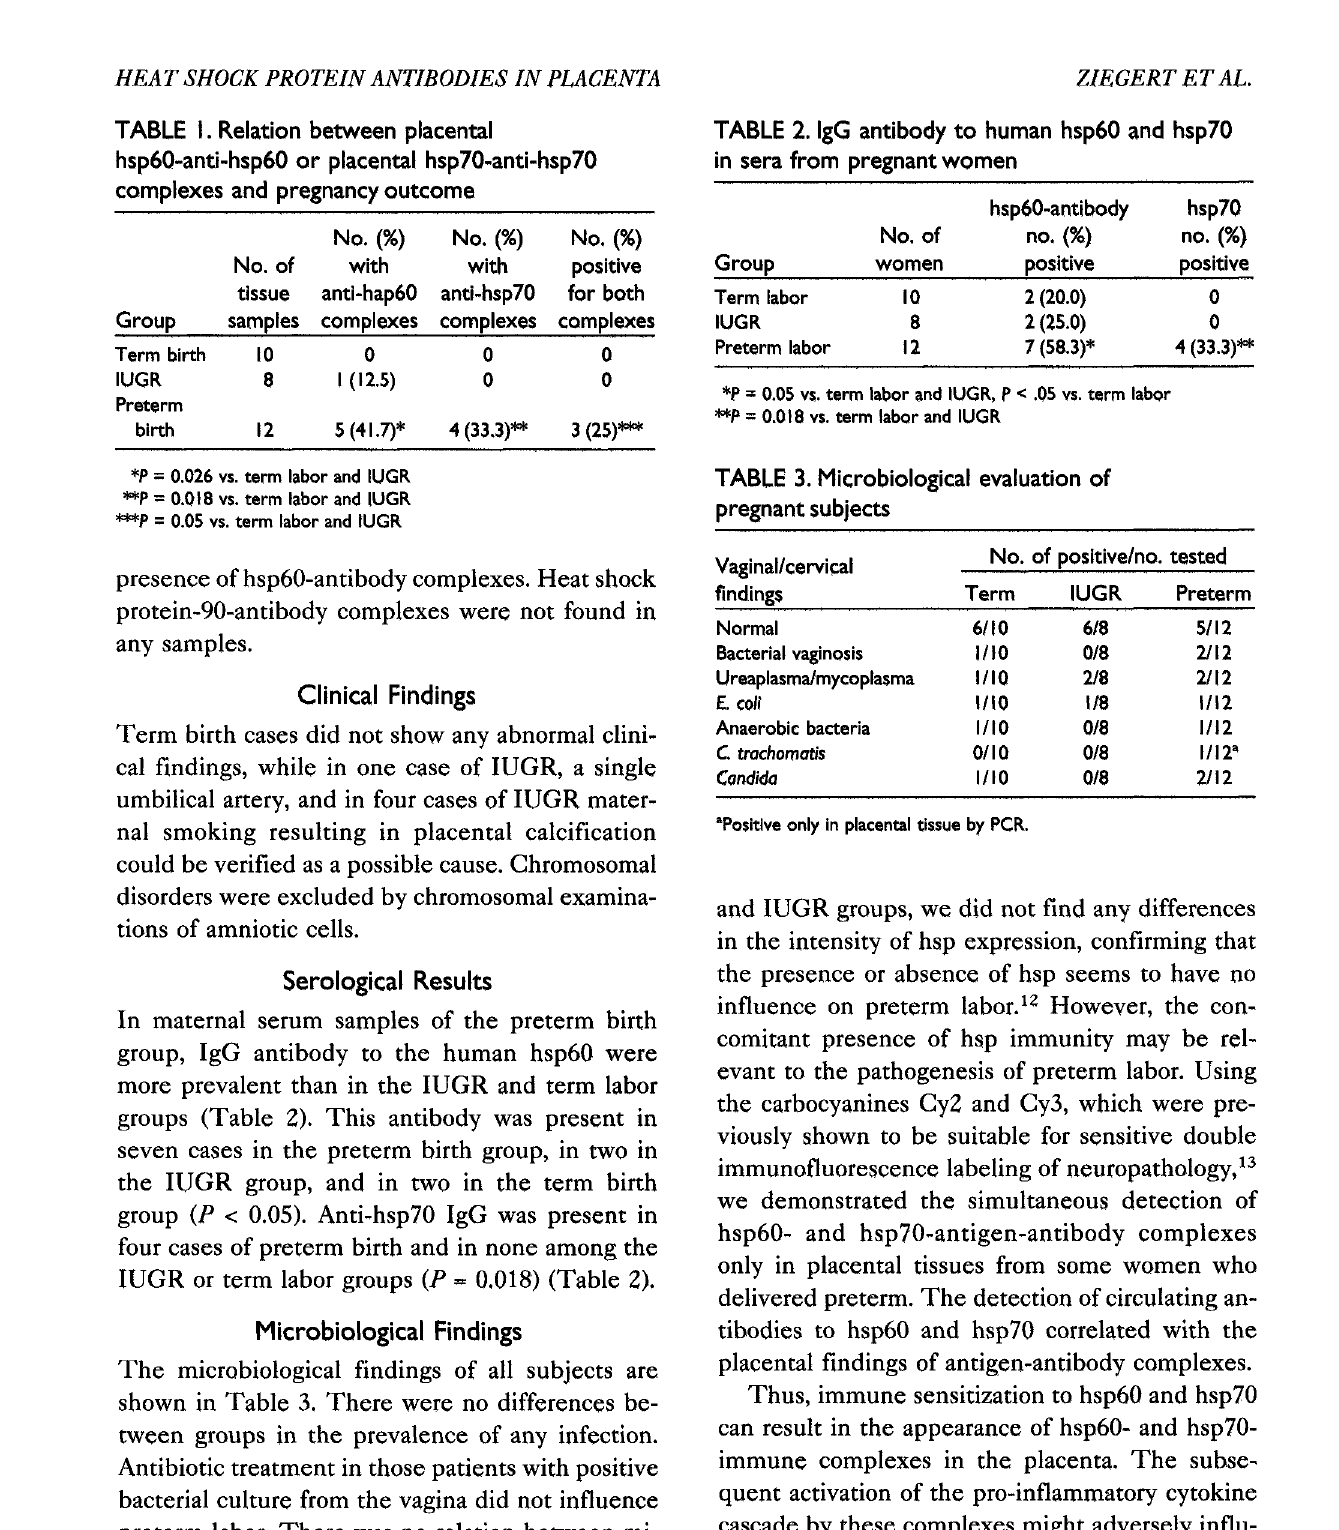
TABLE 3. Microbiological evaluation of pregnant